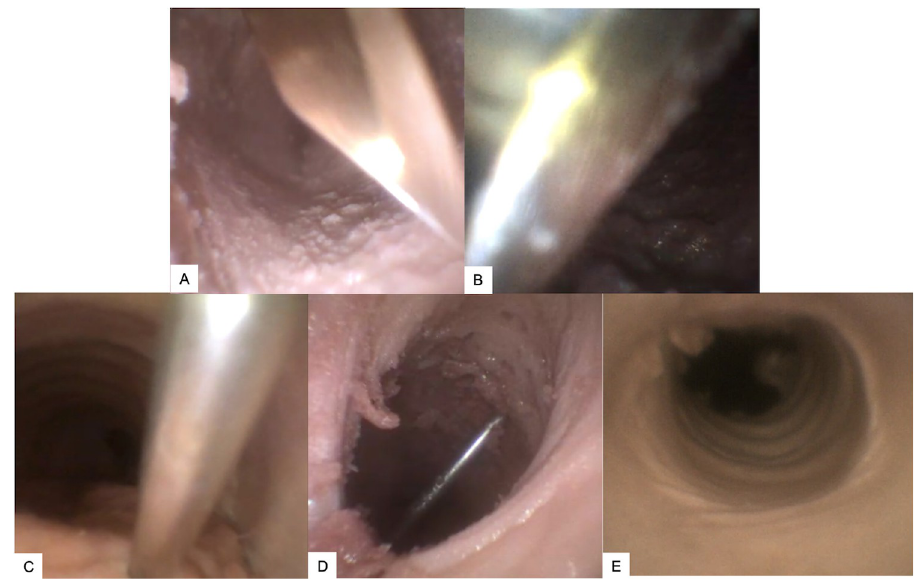
Fig 3. Bronchoscopic capture of complications with depiction of the midpoint of the anterior-posterior depth of the trachea. (A) Scalpel puncture of posterior tracheal wall at 4 o’clock position; (B) Scalpel puncture of posterior tracheal wall at 7 o’clock position; (C) Needle puncture of posterior tracheal wall at 6 o’clock position; (D) Needle puncture of posterior tracheal wall at 7 o’clock position; (E) Absence of bougie catheter in trachea after being placed lateral to